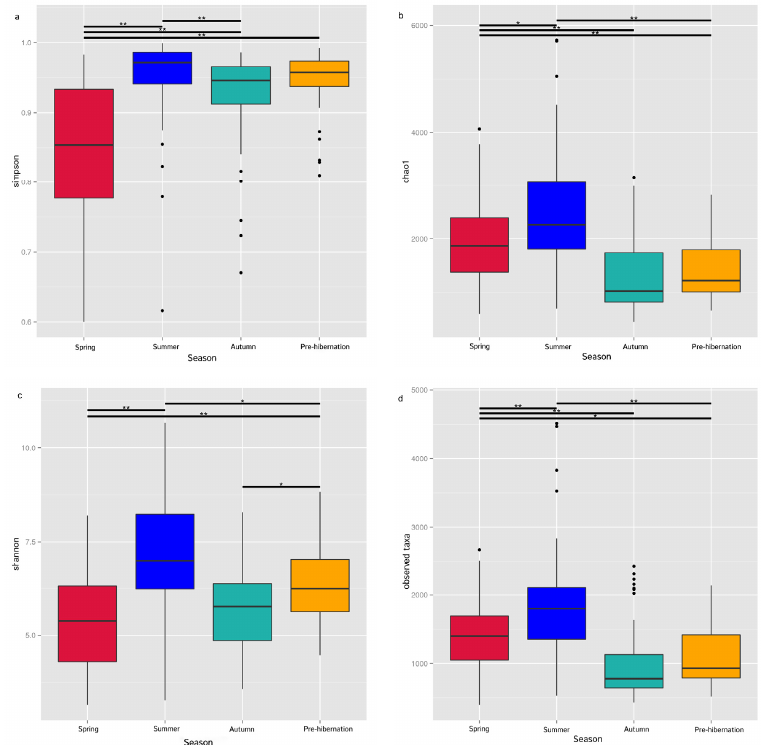
Figure 2. Comparison of alpha diversity of the gut microbiota in F. limnocharis at different seasons (Wilcoxon rank-sum test; p < 0.01 **; and p < 0.05 *). Simpson ( a ), Chao1 ( b ), Shannon ( c ) and observed taxa ( d ). Figure 3